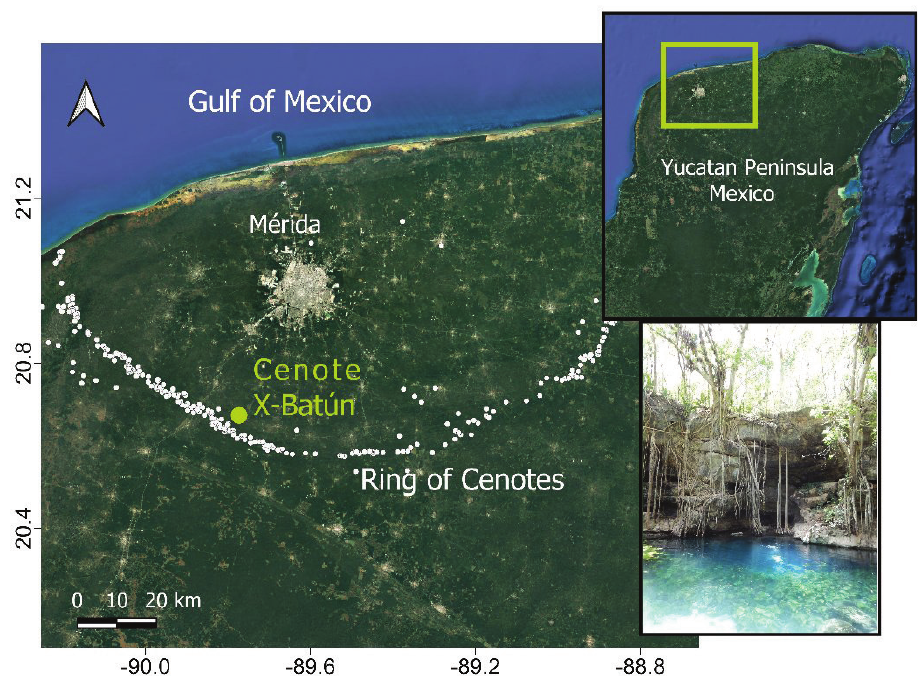
Figure 1. Location of the studied cenote in the Yucatán Peninsula. Yellow dot illustrates the geographical position of Cenote X-Batún within the Ring of